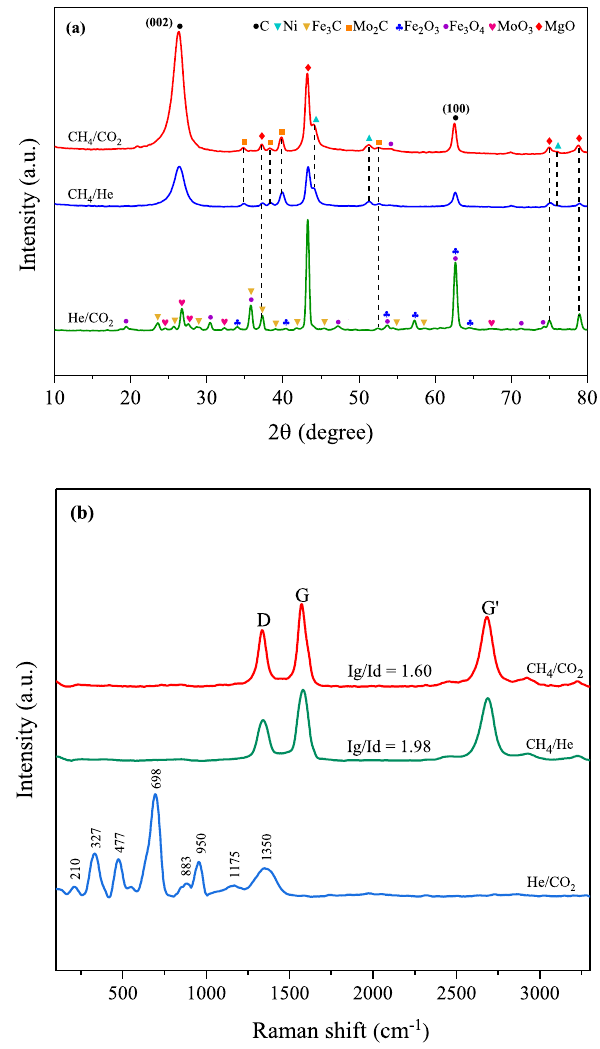
Figure 11. ( a ) XRD patterns and ( b ) Raman spectra of the samples after the reaction over FeNiMo/MgO catalyst at 800 °C for 3